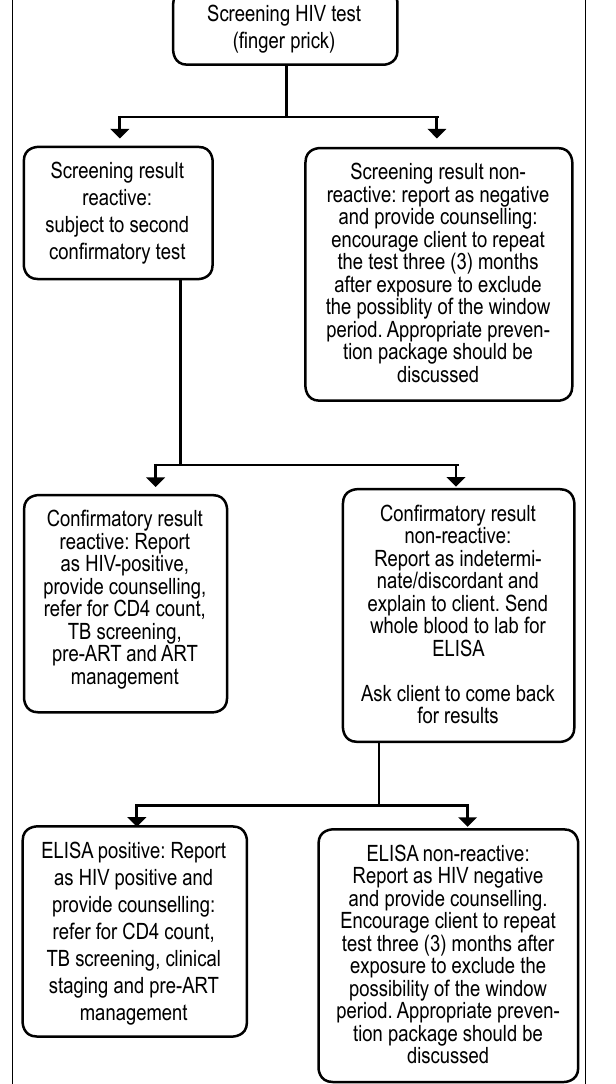
Fig. 2. National HIV testing algorithm (source: HCT